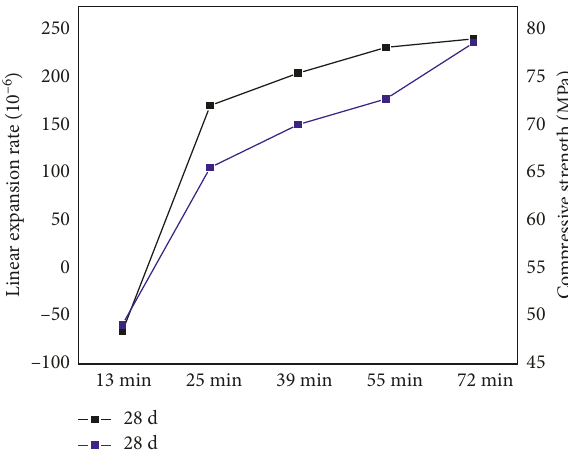
Figure 6: Correlation between the linear expansion rate and compressive strength.